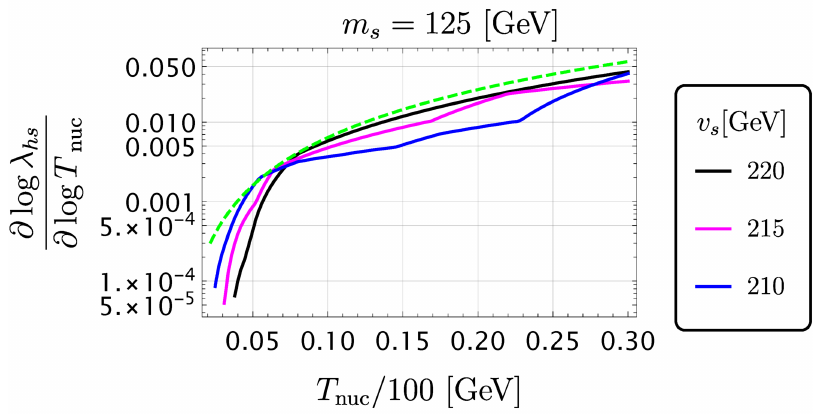
Figure 3 . Tuning of the coupling λ hs as a function of the nucleation temperature. The dashed green line represents the naive tuning ∼ ( T nuc /m h ) 2 . We observe that this naive estimation for the tuning is rather precise at large nucleation temperature but can underestimate the tuning by one order of magnitude for very low nucleation